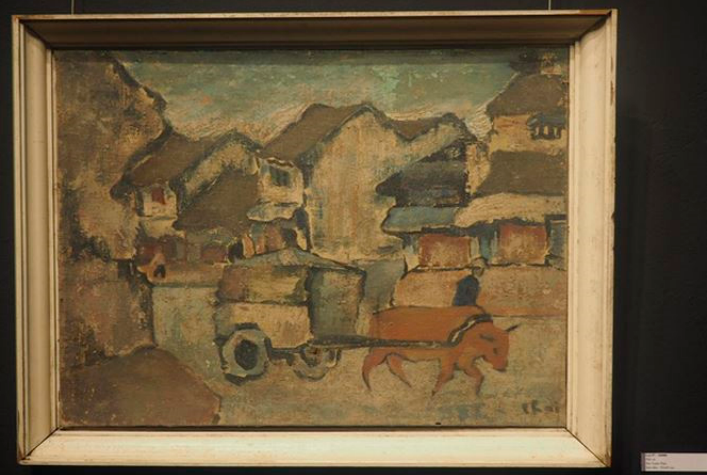
Figure A12. Pho Cu —Bui Xuan Phai. Auctioned at Chon’s, July 2017. The images were sourced from Tien Phong Newspaper (Khanh 2017).